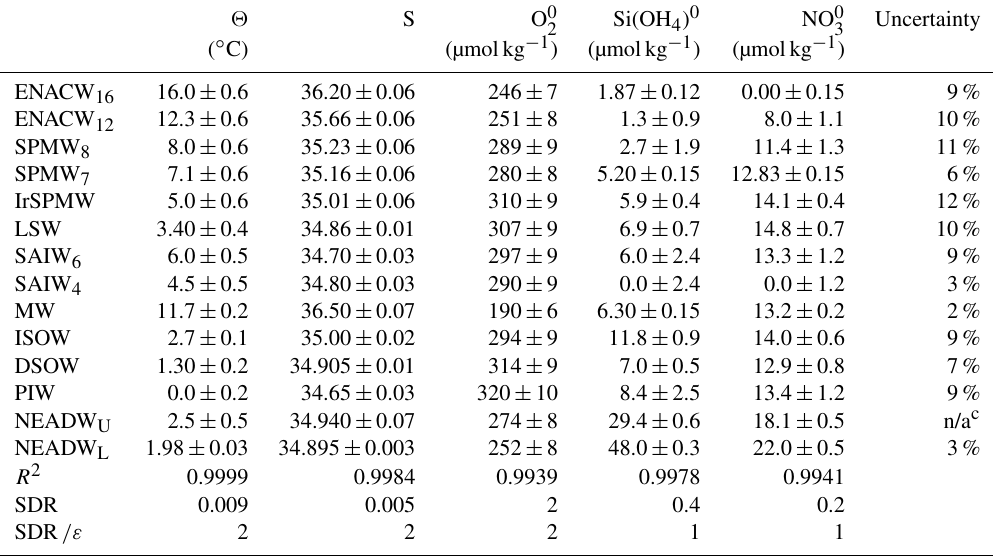
Table 1. Properties characterizing the source water types (SWTs a ) considered in this study with their corresponding standard deviations b . The square of correlation coefficients ( R 2 ) between the observed and estimated properties are also given, together with the standard deviation of the residuals (SDR) and the SDR /ε ratios from the data below 400dbar. The ε (standard deviation of the water sample properties) used to compute the SDR /ε ratios are listed in Table S1. The last column accounts for the uncertainties in the SWT contributions. (cid:50) S O 0 2